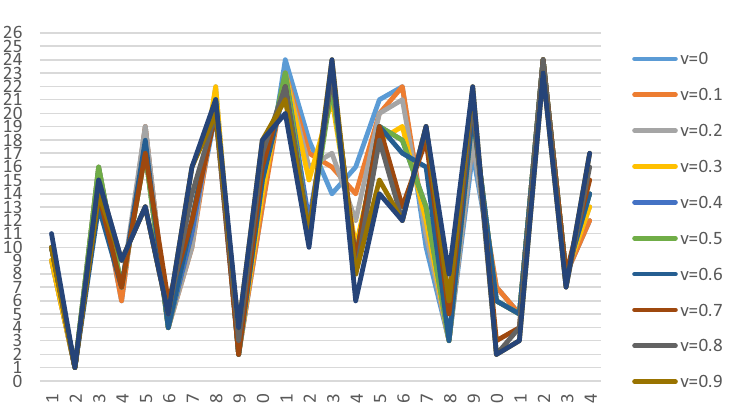
Figure 3. Sensitivity analysis of